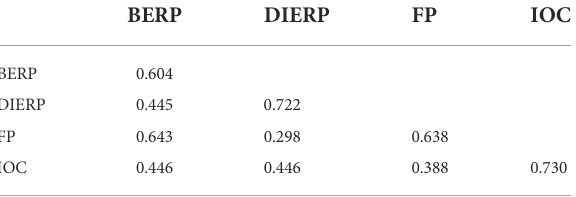
TABLE 4 Results of discriminant validity.